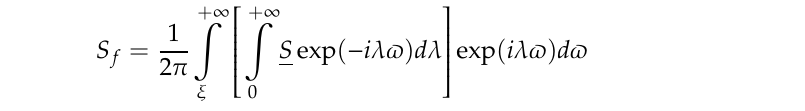
Figure 8. Sensor signal after alignment with the horizontal axis.